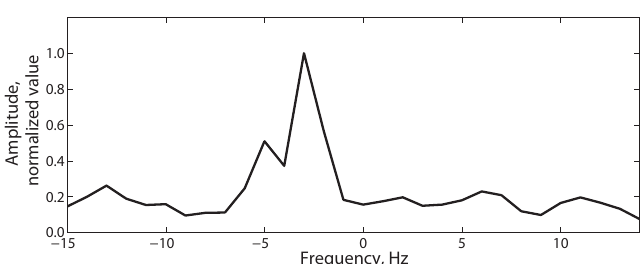
Fig.6. The spectrum of signal as a result of the correlation of the echoes received by the antennas at Irbene and Medicina. Integration time was 1 s, observed on 2013 February 15, 20:01:24 UT. sessions, when the asteroid was at short distance from Earth. A weaker signal was also detected when the distance of 2012 DA14 from the Earth has increased up to 10